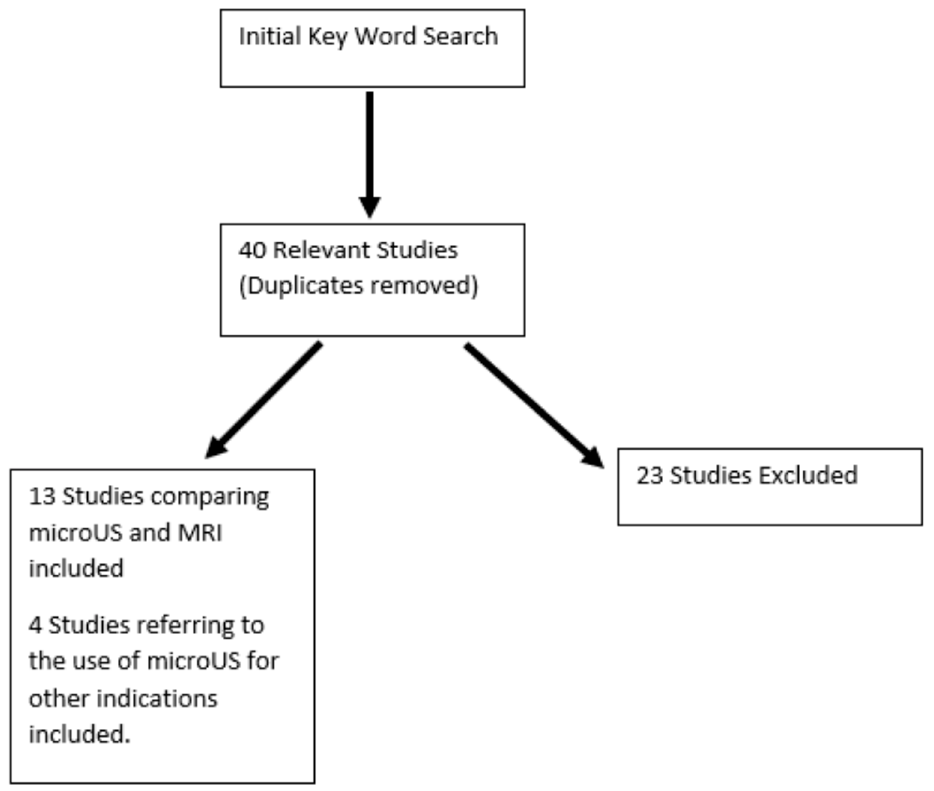
Figure 2. Study search and flowchart for inclusion in the review.